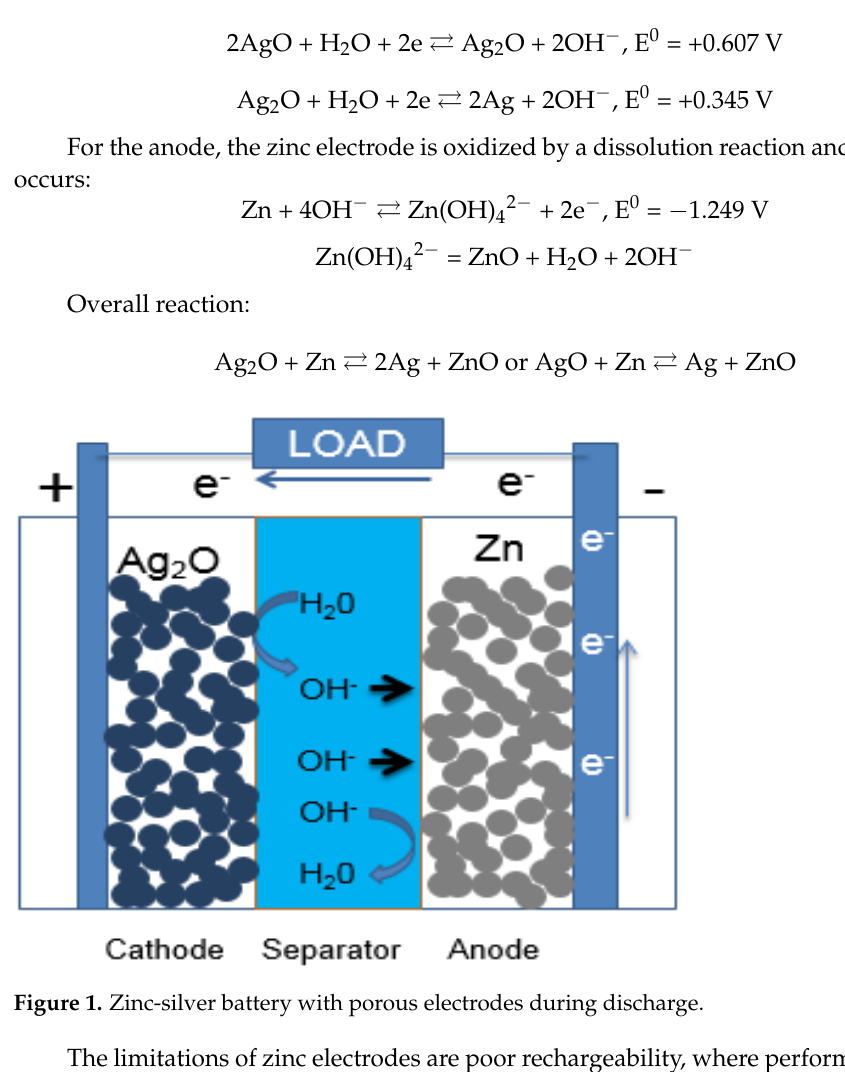
Figure 2. Schematic of the Zn electrode ’ s dendrite phenomenon and the rechargeable limitation of the zinc electrode. Today, to combat the dendrite phenomenon of zinc, many solutions have been stud- ied, such as using new electrodes, binders (electrodes), additives (electrolytes), and charg- ing techniques [28 – 31]. The additives have been studied and introduced as oxides such as